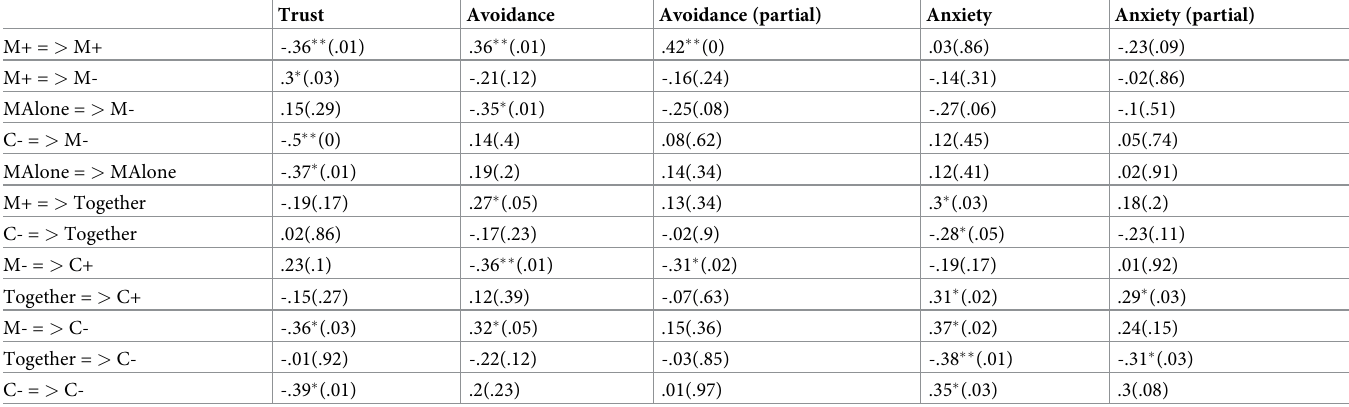
Table 6. Spearman correlations for Trust, Avoidance and Anxiety and partial correlations for Avoidance and Anxiety (controlling pairwise for each other) between sequences of behavior and self-reported attachment ( p -values between brackets).